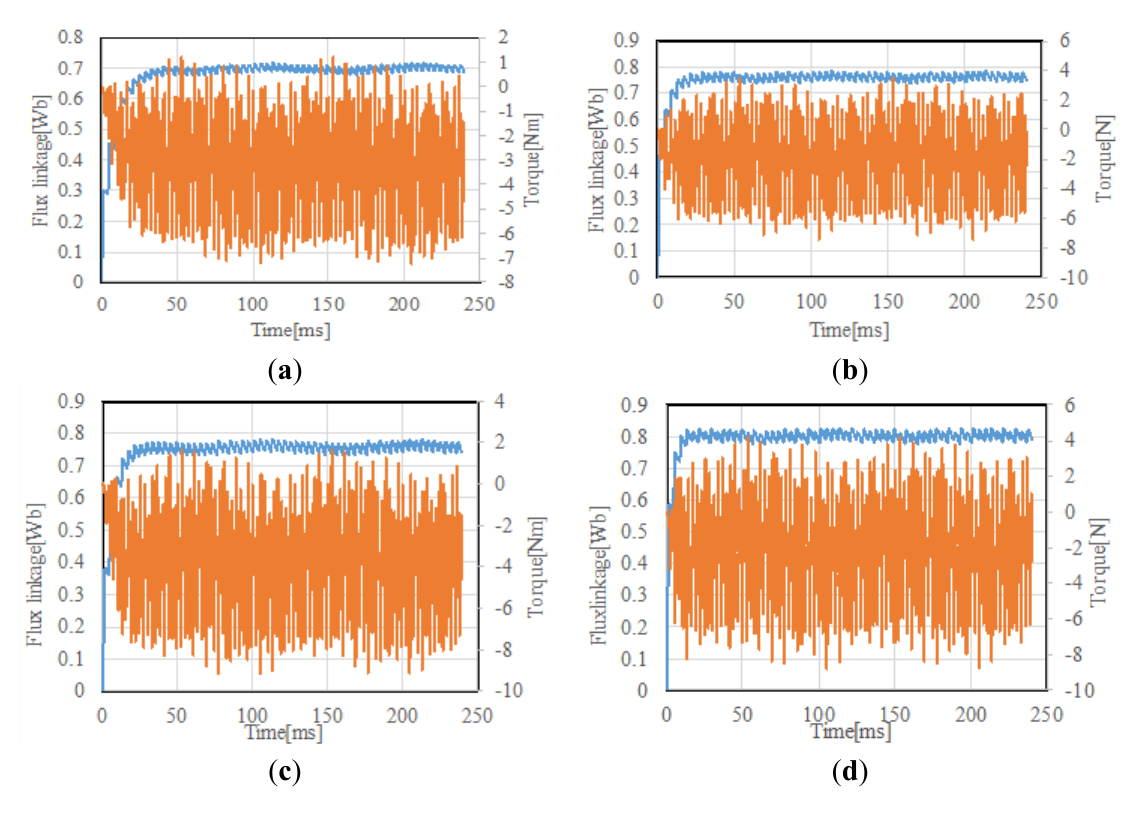
Figure 15. Flux linkage and torque wave form at 600 rpm. ( a ) Triangular wave modulation ( R = 20 Ω); ( b ) triangular wave modulation ( R = 40 Ω); ( c ) sinusoidal wave modulation ( R = 20 Ω); ( d ) sinusoidal wave modulation ( R = 40